Question: What form of chart is displayed?
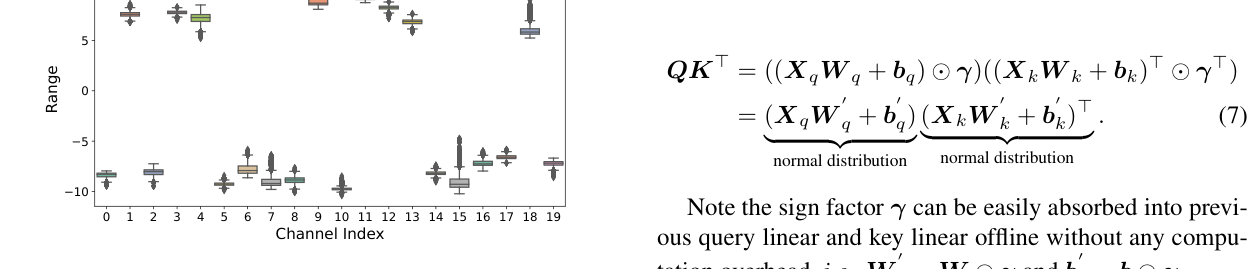
Answer: box